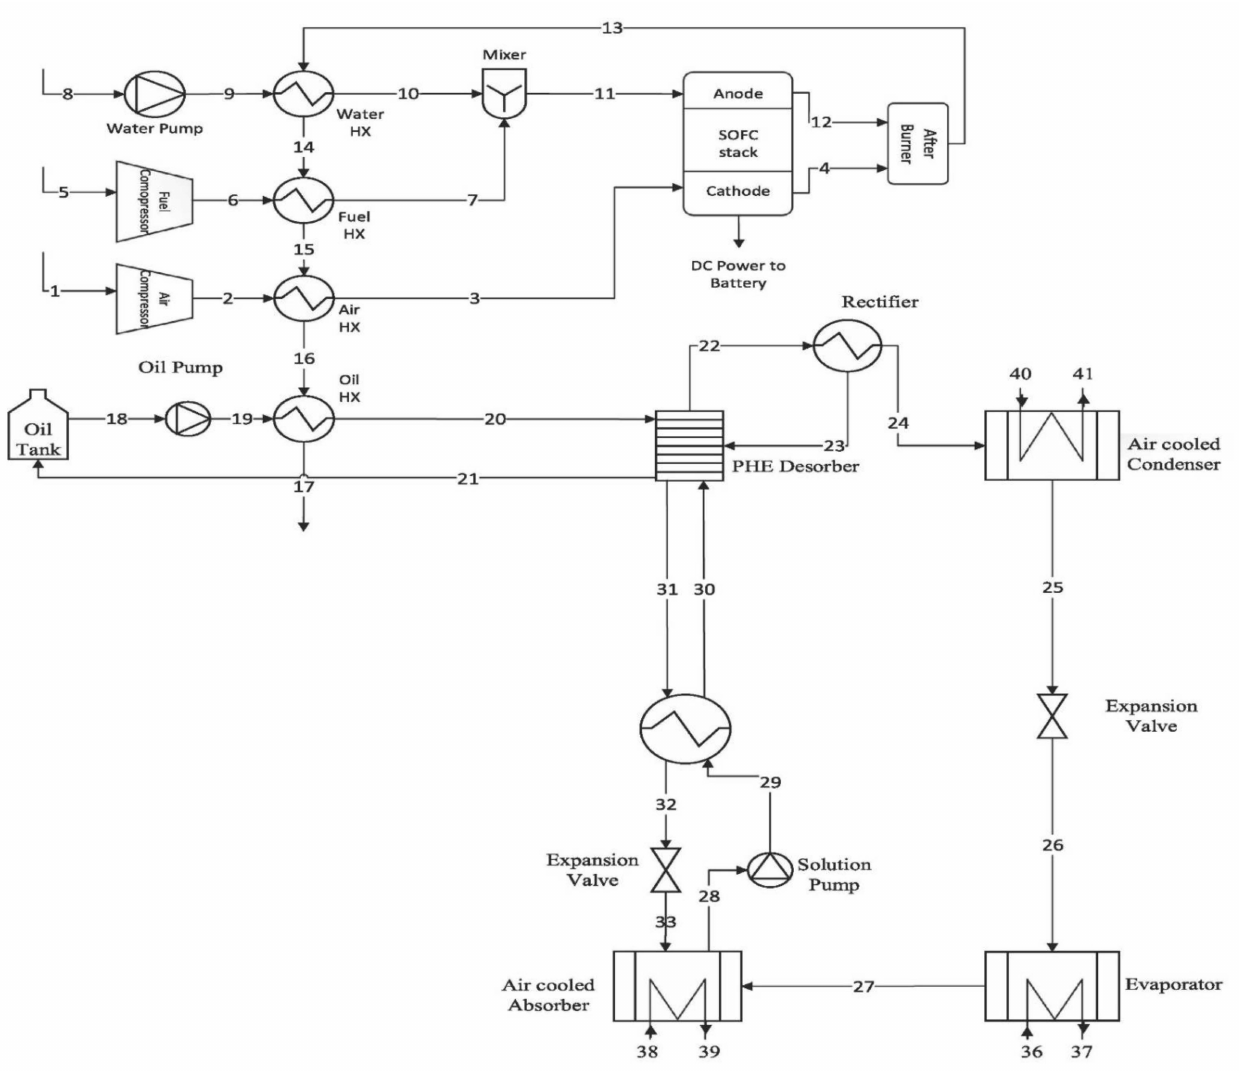
Figure 16. Series configuration of heat exchangers. Reprinted from ref. [57] (Pandya et al., 2020), Copyright (2020), with permission from